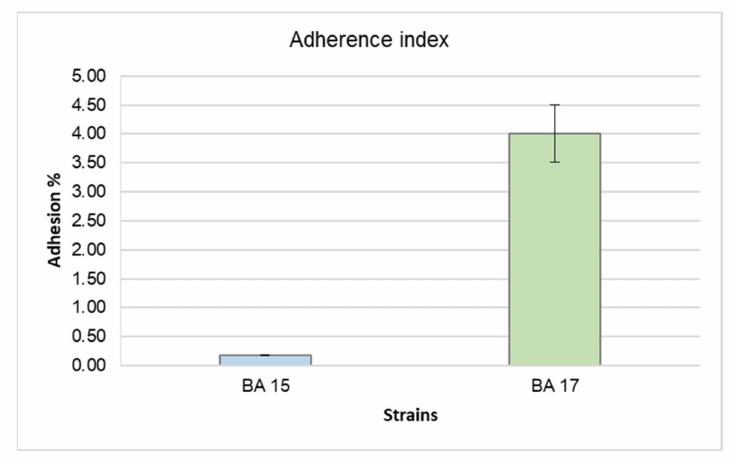
Figure 2. Adherence index of the Bifidobacterium asteroides BA15 and Bifidobacterium asteroides BA17 strains on an abiotic surface.